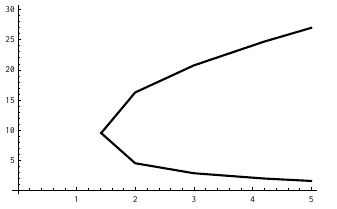
Figure 6. Approximation of the solution curve.